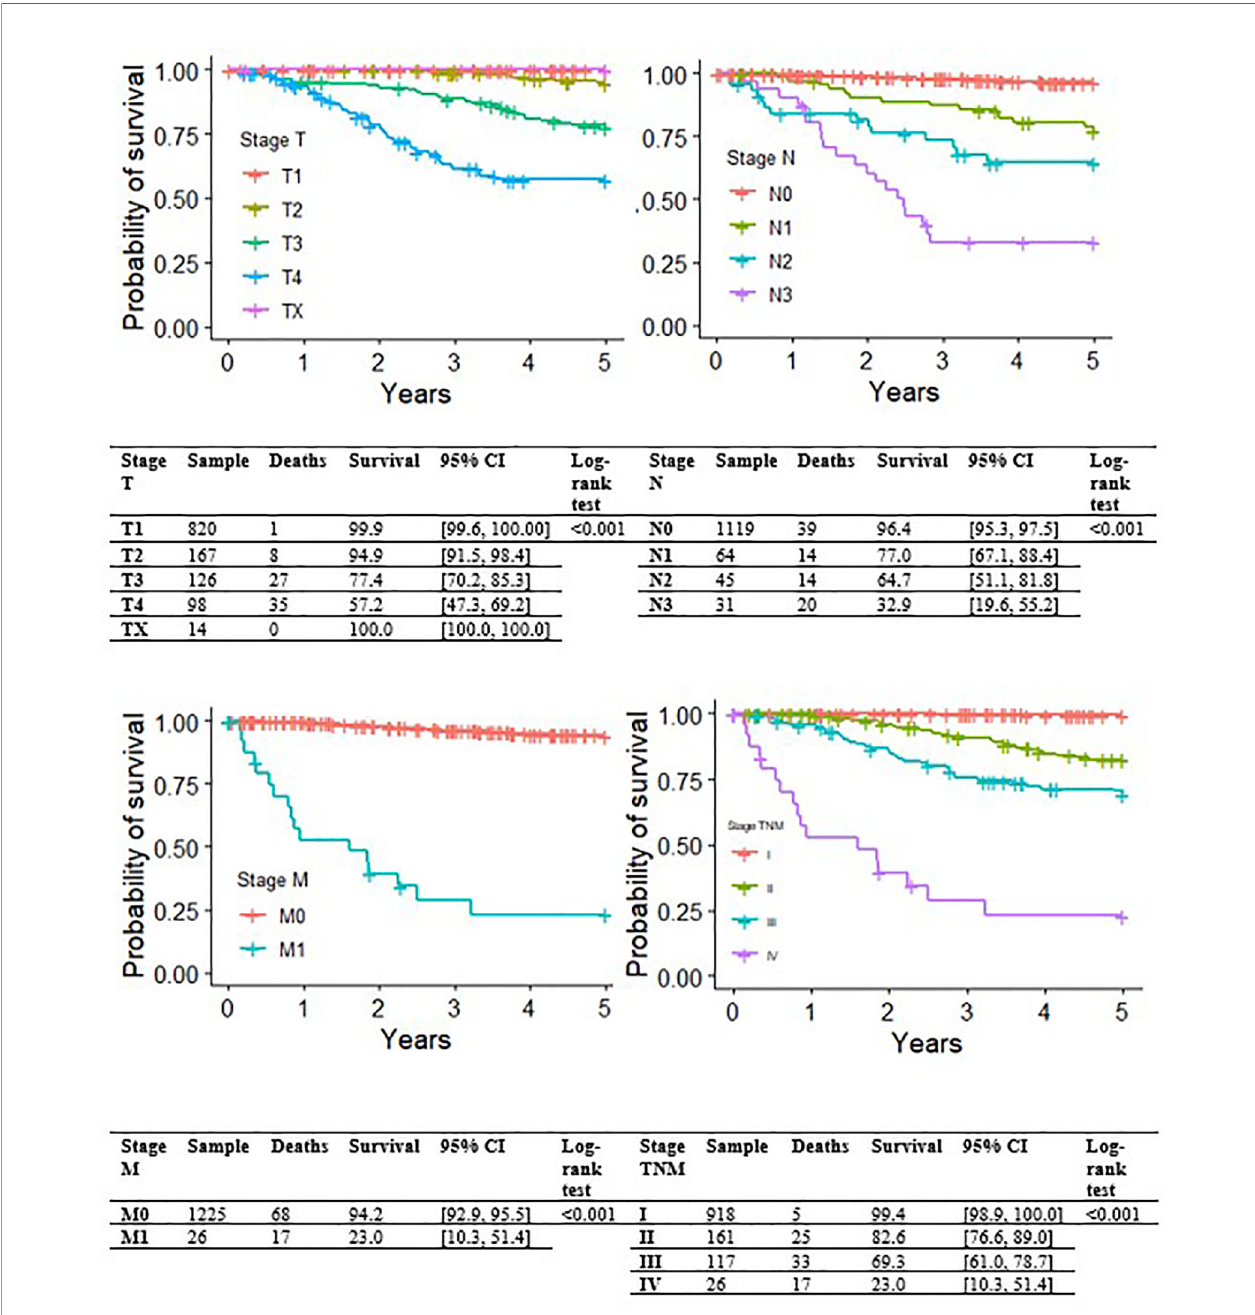
FIGURE 1 | Kaplan-Meier curves for melanoma-speci fi c survival by stage (T, N or M, and TNM